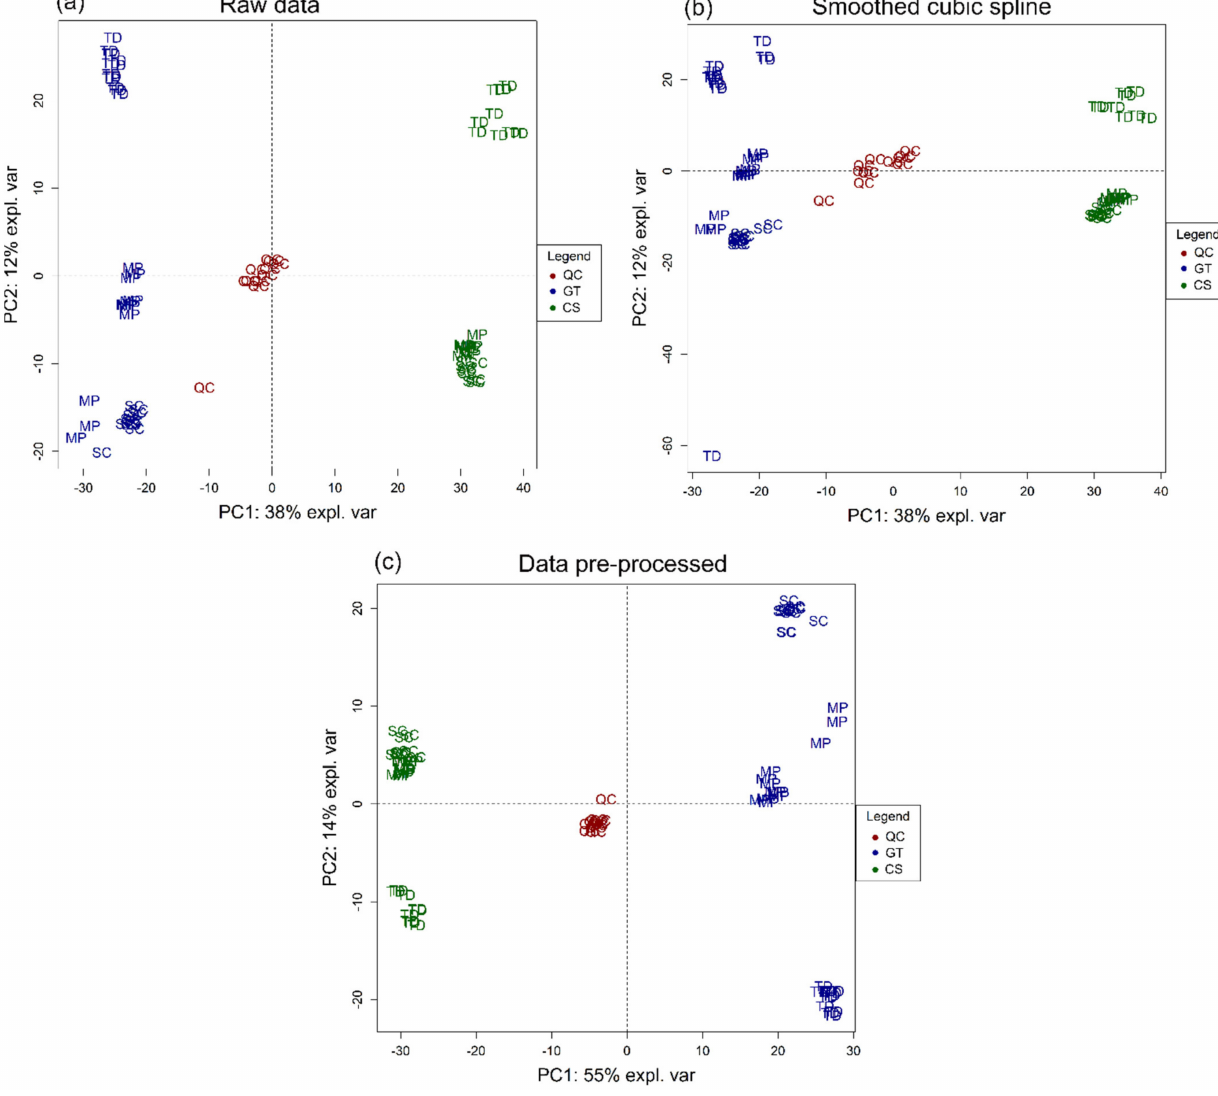
Figure 5. Principal component analysis (PCA) performed for the LC positive ESI mode data during pre-treatment. ( a ) Raw data, ( b ) after smoothed cubic spline and ( c ) pre-treated data. Quality control samples (QCs) are included to verify the quality of the data. TD : wines fermented with sequential inoculation of Torulaspora delbrueckii and Saccharomyces cerevisiae . MP : wines fermented with sequential inoculation of Metchnikovia pulcherrima and Saccharomyces cerevisiae . SC : wines fermented with monoculture of Saccharomyces cerevisiae